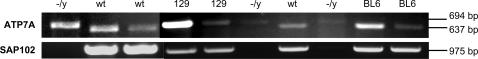
PCR genotyping results for Atp7a and Dlgh3 genomic regions.Two bands were observed for Atp7a reactions, one of 694 bp corresponding to 129-derived sequences and another of 637 bp corresponding to C57Bl6-derived sequences (upper panel). The appearance of the 694 bp-band coincided with the presence of the SAP102 mutation (-/y) (lower panel). Wild-type 129S5 (129) and C57BL/6j (BL6) were used as positive controls.